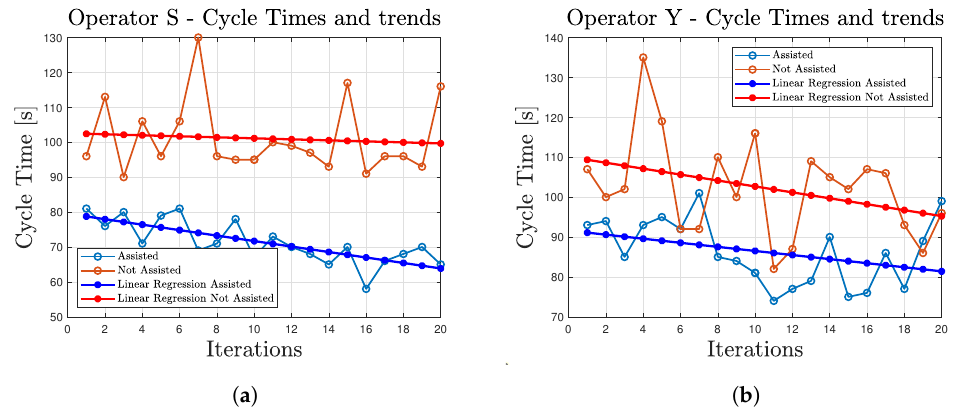
Figure 13. Learning rates. ( a ) Operator S. ( b ) Operator